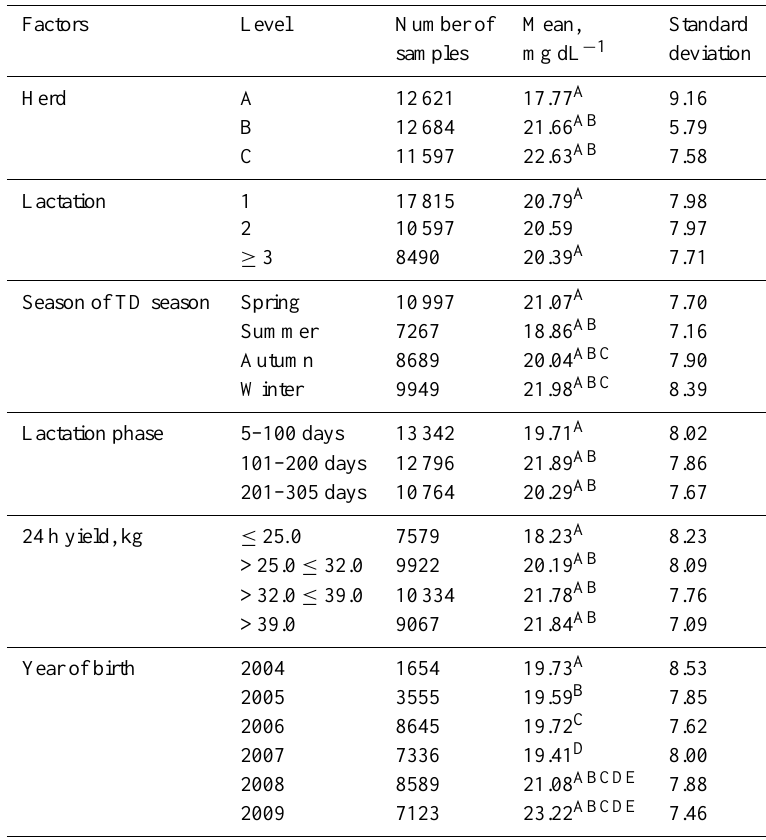
Table 3. Level of urea in milk with respect to selected factors. Factors Level Number of